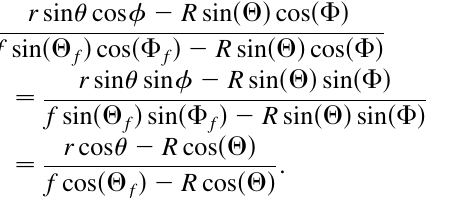
FIG. 2. Beam focal spot and the target. ( R; (cid:27) ; (cid:28) ) means the beam position at the tangential target surface, ( f; (cid:27) focal position, and ( r; (cid:13); (cid:14) ) is the beam particle orbit in the